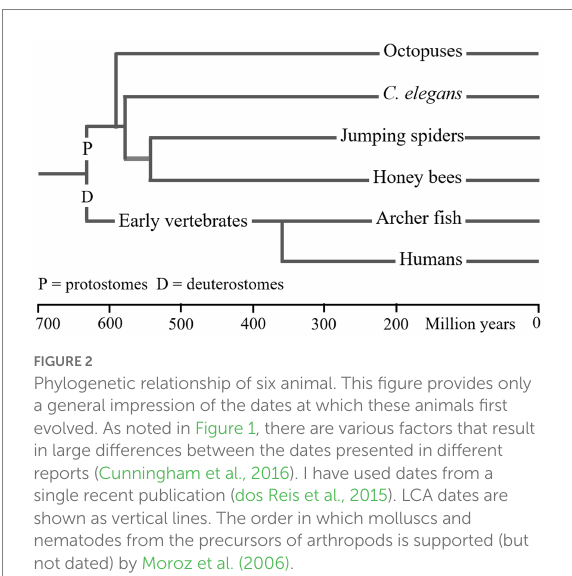
FIGURE 2 Phylogenetic relationship of six animal. This figure provides only a general impression of the dates at which these animals first evolved. As noted in Figure 1, there are various factors that result in large differences between the dates presented in different reports (Cunningham et al., 2016). I have used dates from a single recent publication (dos Reis et al., 2015). LCA dates are shown as vertical lines. The order in which molluscs and nematodes from the precursors of arthropods is supported (but not dated) by Moroz et al.